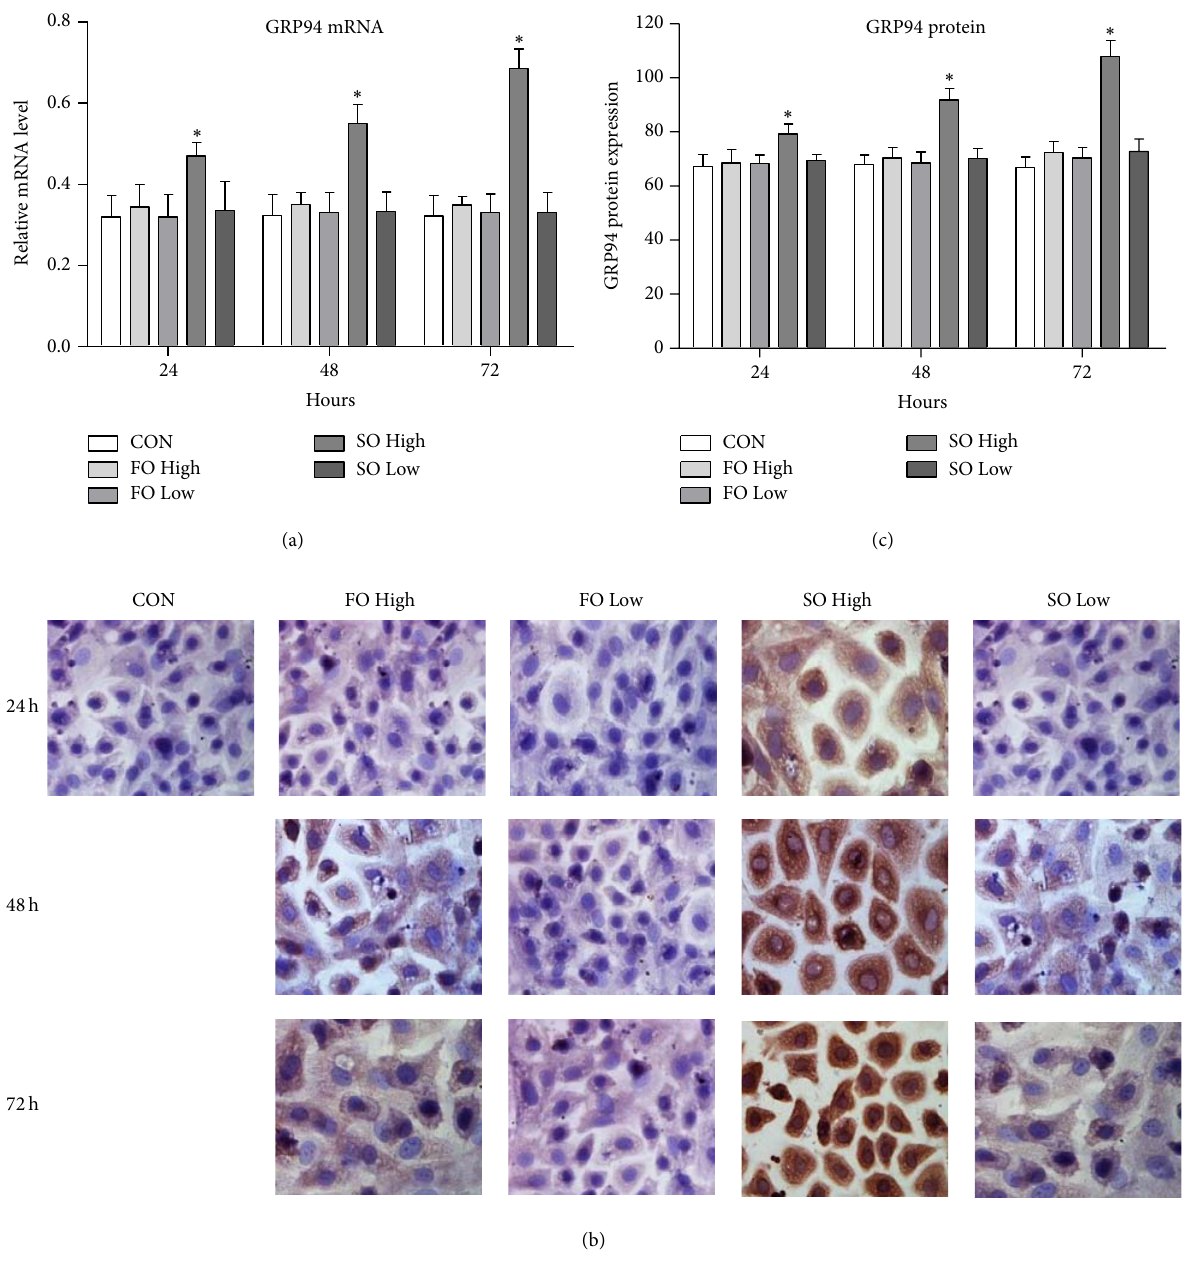
Figure 4: Soybean oils but not fish oils upregulate GRP94 mRNA and protein levels. Primary hepatocytes were treated with 0.4% or 1% soybean or fish oil-based lipid emulsions. The GPR94 mRNA expression (a) was detected using qRT-PCR and GRP94 protein expression (b, c) was detected by immunohistochemistry at the indicated time points; ∗ 𝑝 < 0.05 versus CON. GRP, glucose-regulated